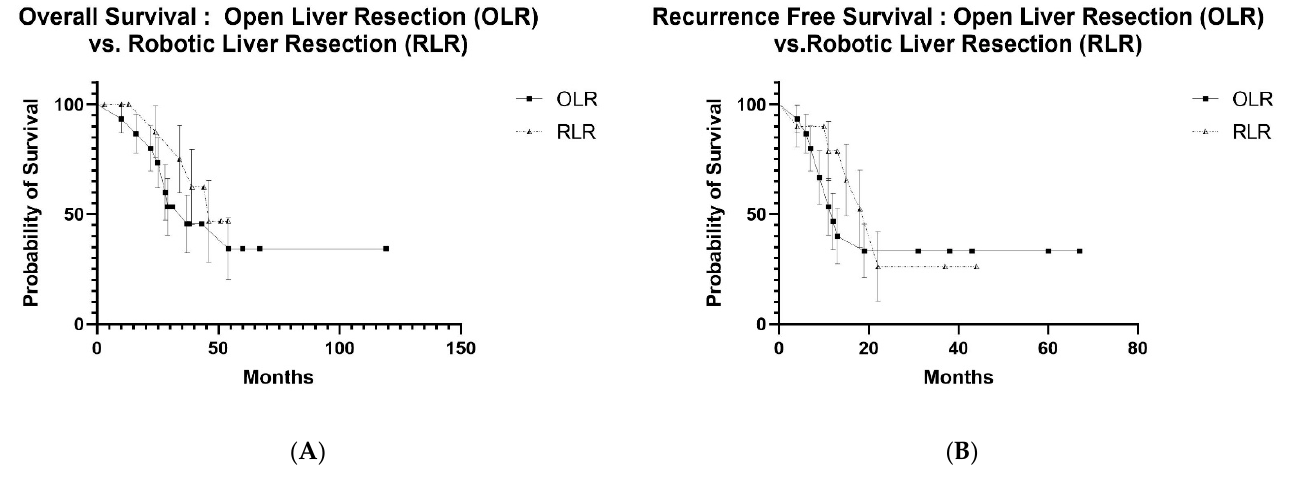
Figure 1. ( A ) Overall survival curves for open liver resection (OLR) vs. laparoscopic liver resection (LLR) after propensity score matching (PSM) for colorectal liver metastases (CRLMs), ( B ) recur- rence-free survival curves for open liver resection (OLR) vs. laparoscopic liver resection (LLR) after propensity score matching (PSM) for colorectal liver metastases (CRLM).